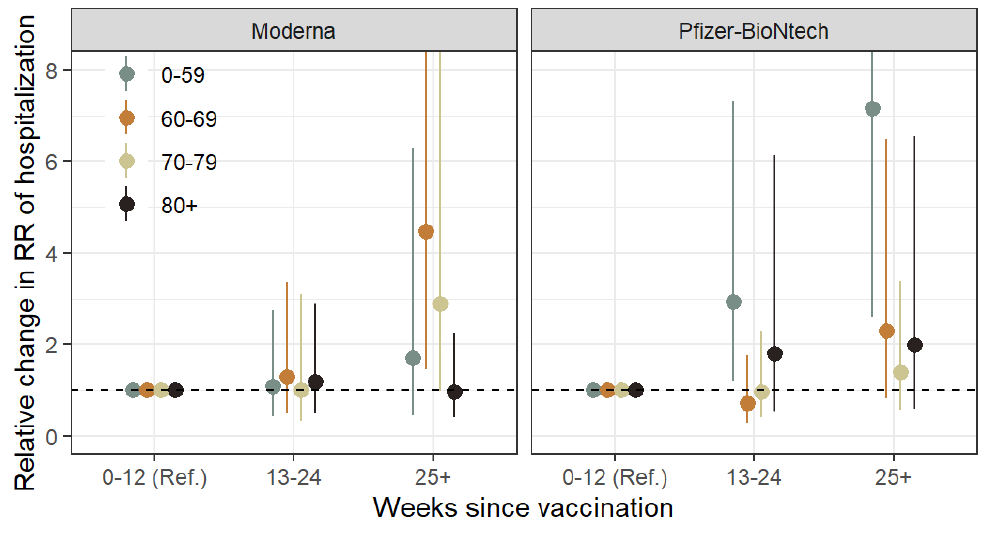
Figure S5. Relative change in the RR of hospitalization for individuals fully-vaccinated with Pfizer- BioNtech compared to individuals fully-vaccinated with Moderna, overall, by age group, and by